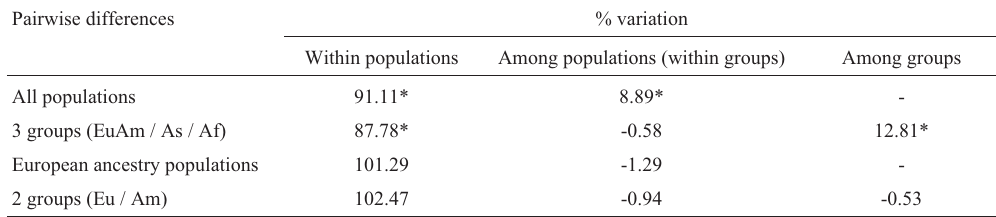
Table 2 - Analysis of Molecular Variance (AMOVA) among worldwide populations. Values indicate variance component in hierarchical levels in four genetic structures tested. Asterisks mark statistically significant values (significance test: 1023 permutations, p < 0.05). Pairwise differences